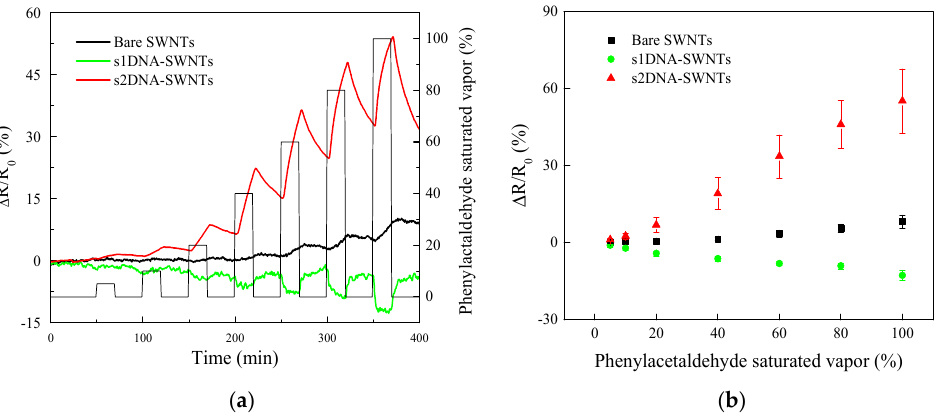
Figure 6. ( a ) Dynamic responses of bare and single-stranded DNA (ssDNA)-coated SWNT sensors toward different concentrations of phenylacetaldehyde vapors performed at V DS = 0.1 V. ( b ) Calibration curves for bare and ssDNA-coated SWNT devices. Each data point is an average of measurements from four independent biosensors.